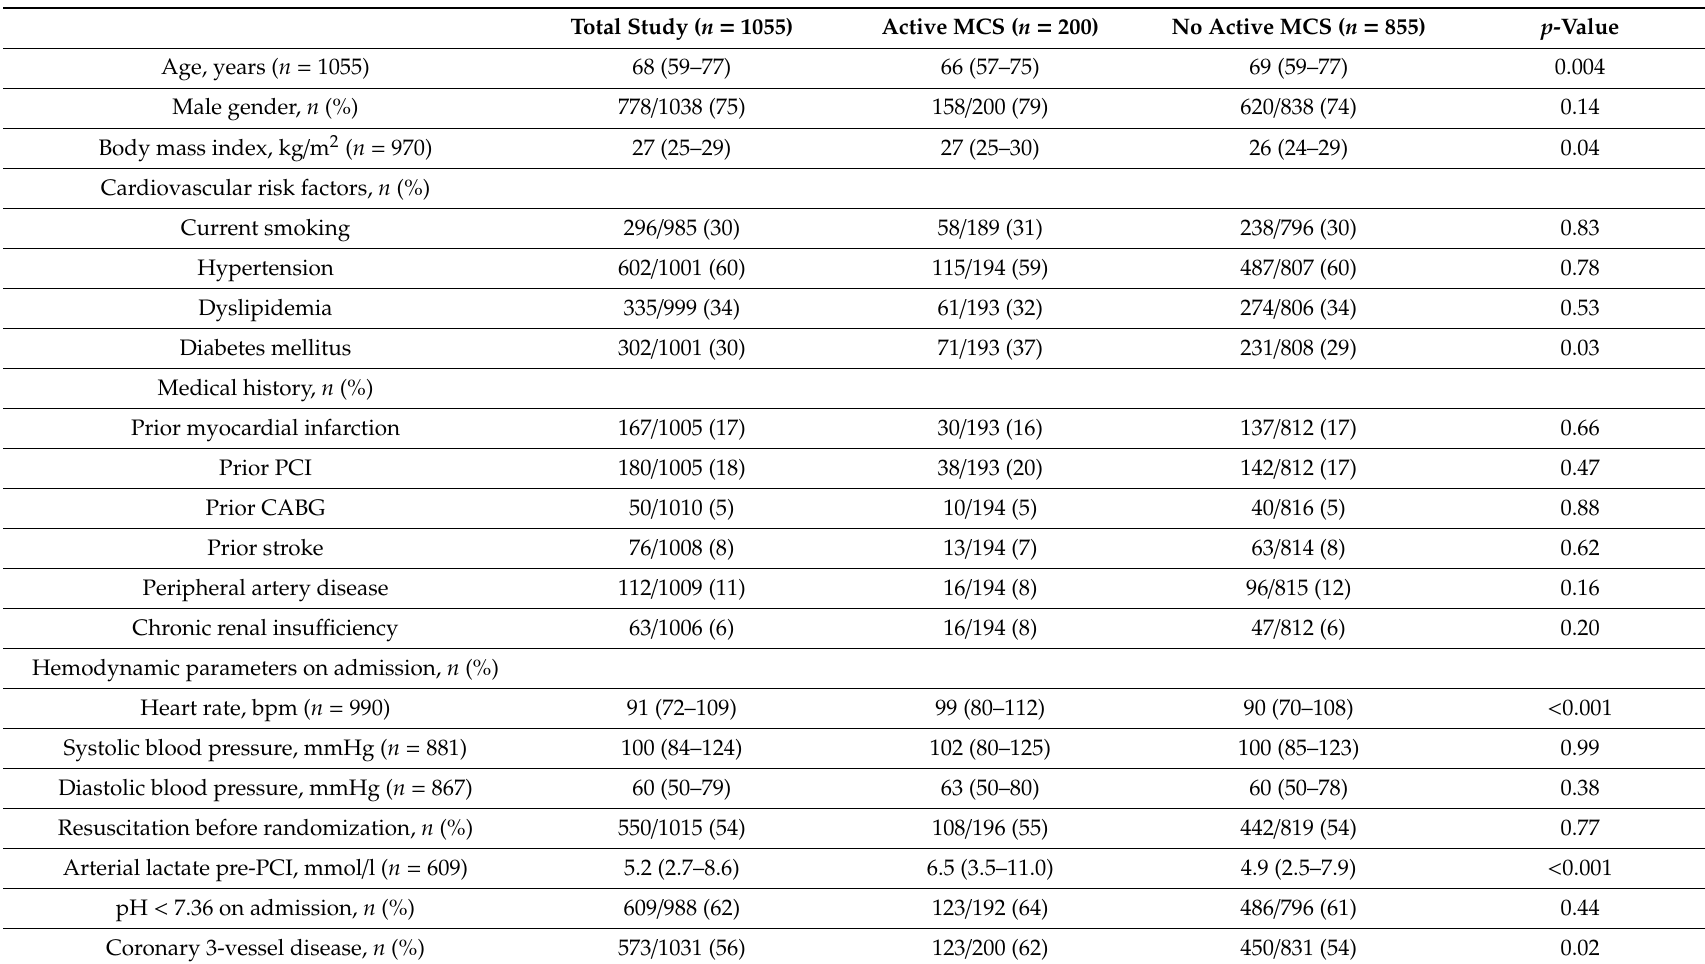
Table 1. Baseline